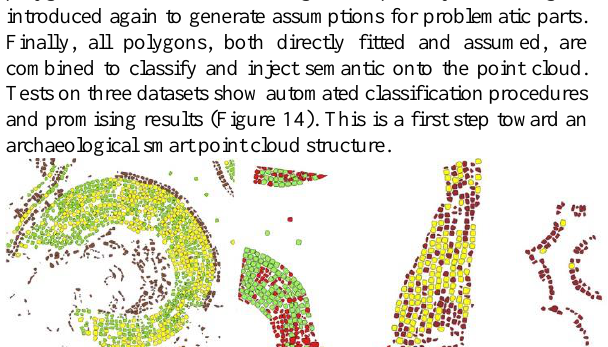
(Figure 15). Yet, an efficient registration as illustrated is mandatory for accurate